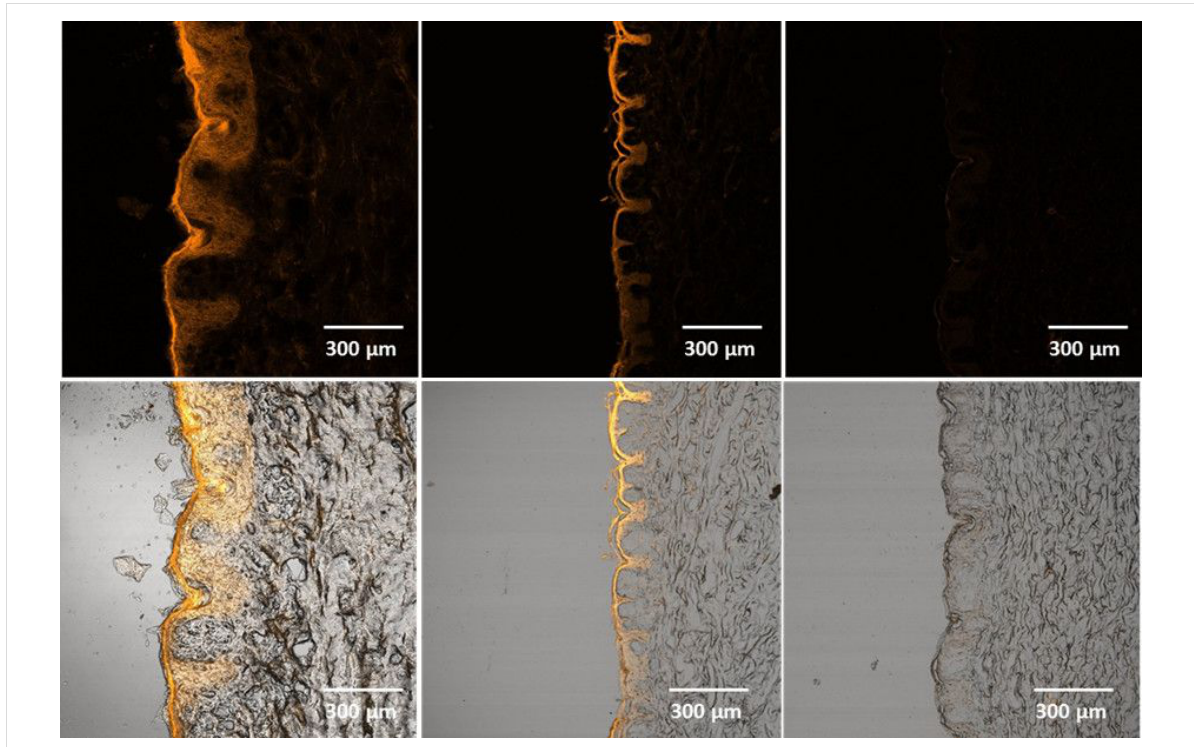
Figure 8: Penetration of curcumin into pig ear skin, vertical pig ear slices, fluorescence microscopy images (upper row) and overlay of fluorescence and light microscopy images (lower row); after application of 0.2% curcumin suspension in SmartLipids (left column), 2.0% curcumin micrometer-size crystal suspension (middle) and a commercial curcumin containing gel product (right). Incubation time was 24 h. Both laser strength (35%) and fluo- rescence detector gain (720 V) were kept constant during all